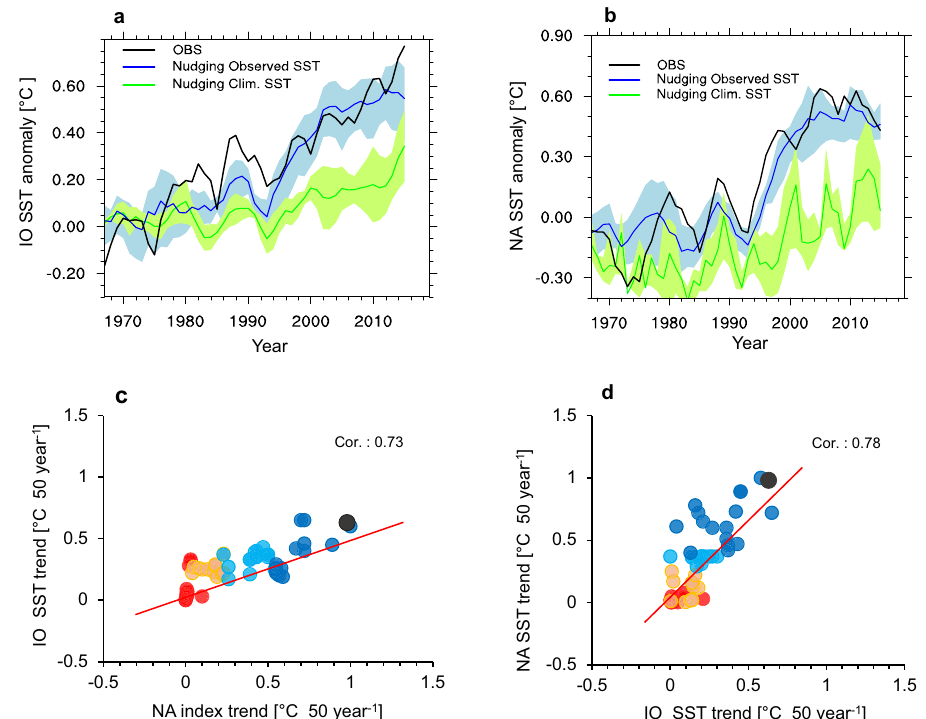
Fig. 5 Indian Ocean (IO) - North Atlantic Ocean (NA) warming trends simulated via historical experiments. a , b Historical simulation with observed NA (or IO) SST. Temporal evolution of the IO index derived from historical simulations with the observed SST anomalies (blue) and climatological SST (green) prescribed over ( a ) the NA and ( b ) the IO regions. The black curve denotes the observed IO index. The blue (green) curves represent the model ensemble mean, and the light blue (green) shadings show the ensemble spread. The black lines denote the observations. c , d Historical simulation with observed NA (or IO) SST pattern and different trends for 1950 ‒ 2020 Scatter plots between IO and NA index trends (°C) per 50 years derived from the historical simulations with prescribed ( c ) NA warming trends and ( d ) IO warming trends. Two groups of historical experiments were used for analysis. In the fi rst group, observed NA warming signals were engaged in the model by nudging the observed SST anomalies with various trends for the NA